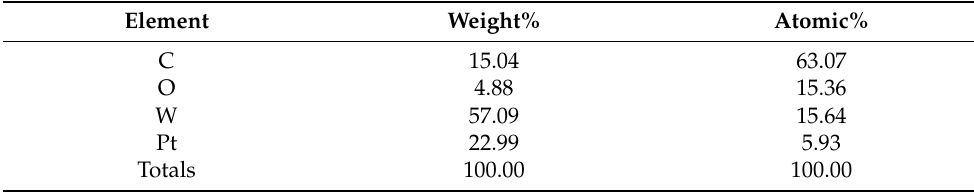
Figure 2. FESEM micrographs of: ( a ) WC precursor, ( b ) WC catalyst, ( c ) Pt/WC catalyst (inset of EDS spectrum), ( d – g ) element mapping images of the Pt/WC catalyst, including C, W and Pt elements. Table 1. The element content of the Pt/WC catalyst via EDS analysis.